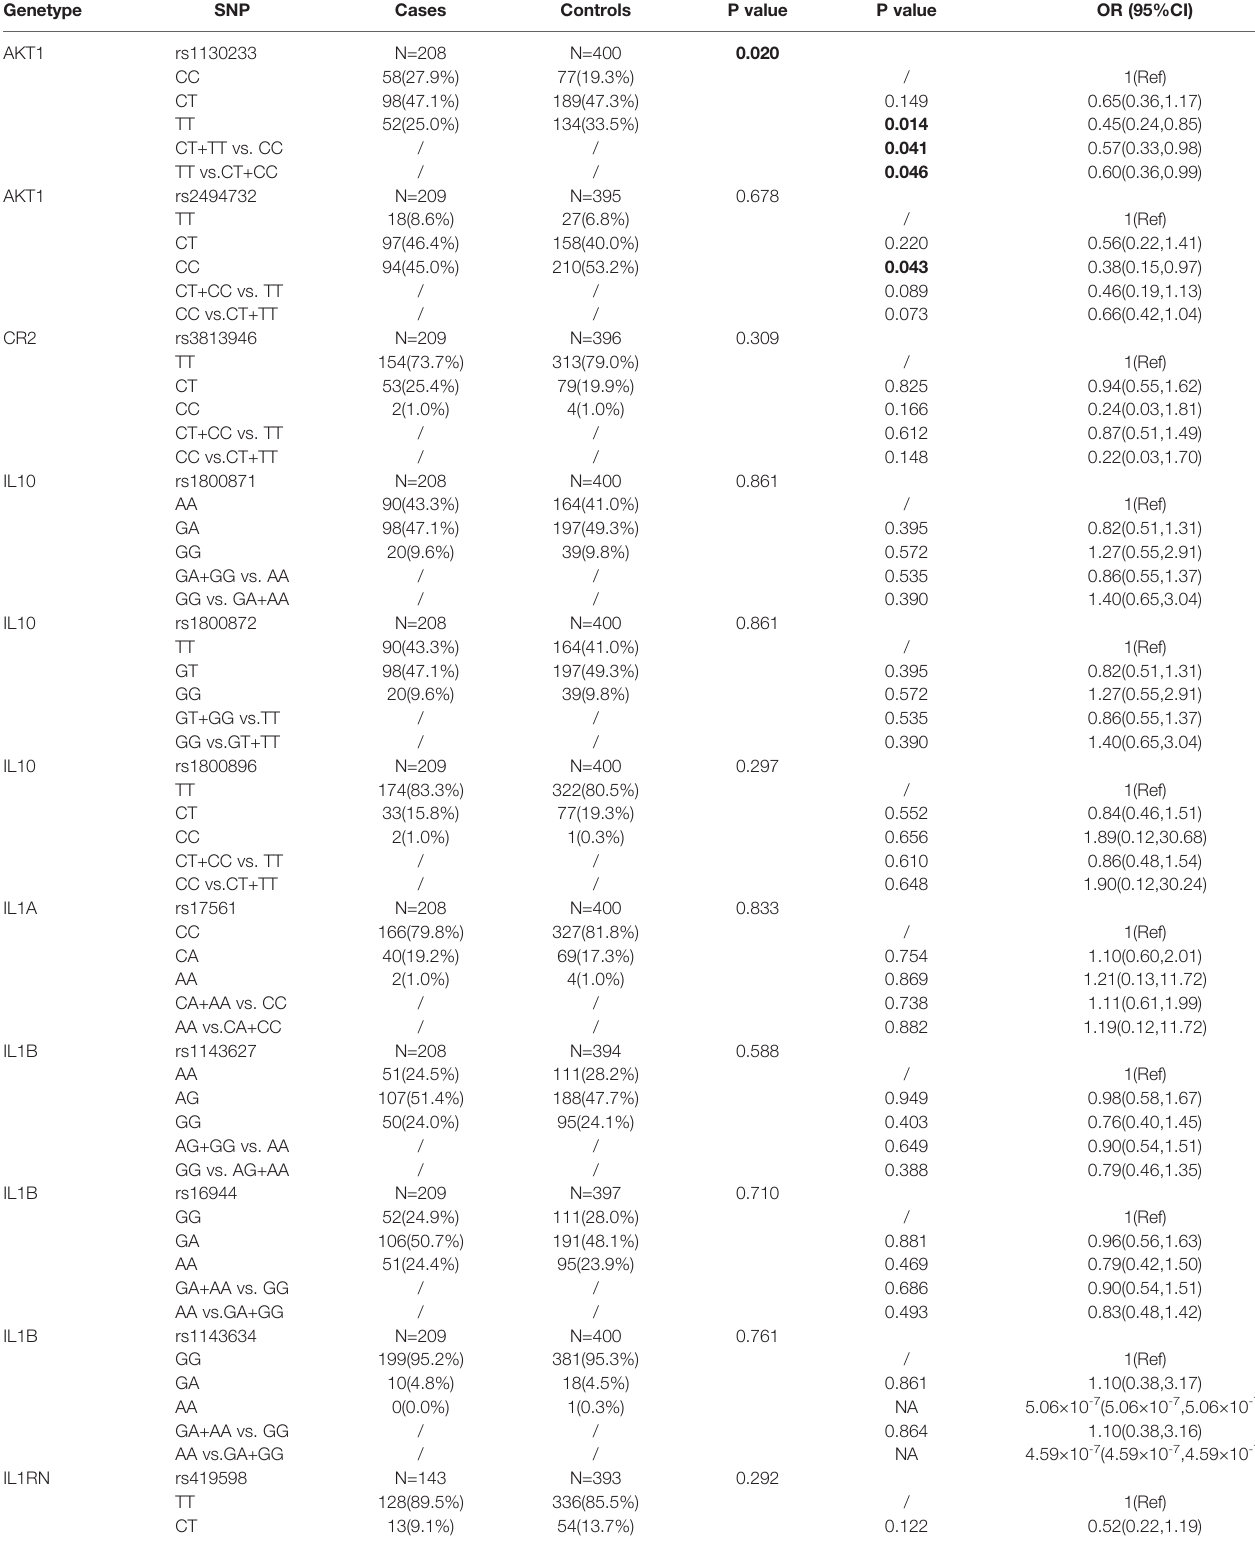
TABLE 2 | Association of 28 in fl ammation-associated gene SNPs with HNSCC risk.